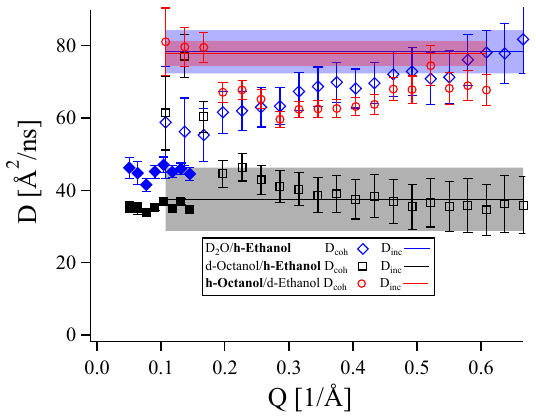
Figure 4. Coherent (empty squares) and incoherent (constant line) di ff usion coe ffi cients extracted from IN11C measurements over the whole Q range three mixtures: B1 d-water / h-ethanol, B2 d-ethanol / h-octanol, B2 h-ethanol / d-octanol, in the respective fractions of 0.14, 0.61, 0.66 mol of ethanol. Full squares are extracted from IN15 measurements. The colored zones represent the error bar on D inc